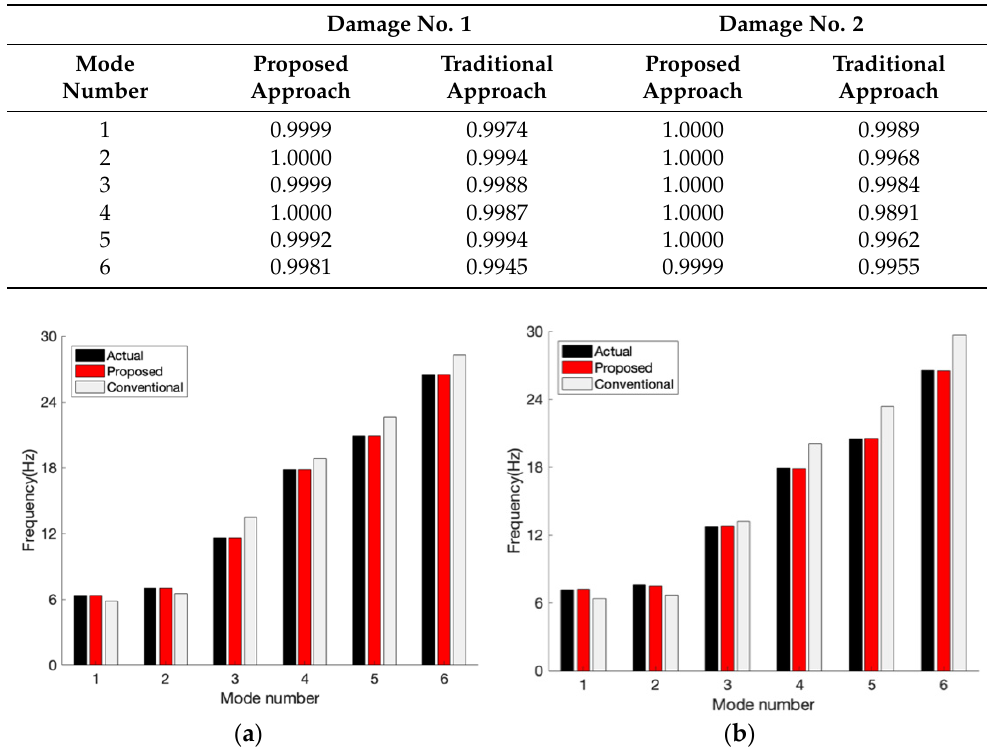
Table 9. MAC values by two approaches.